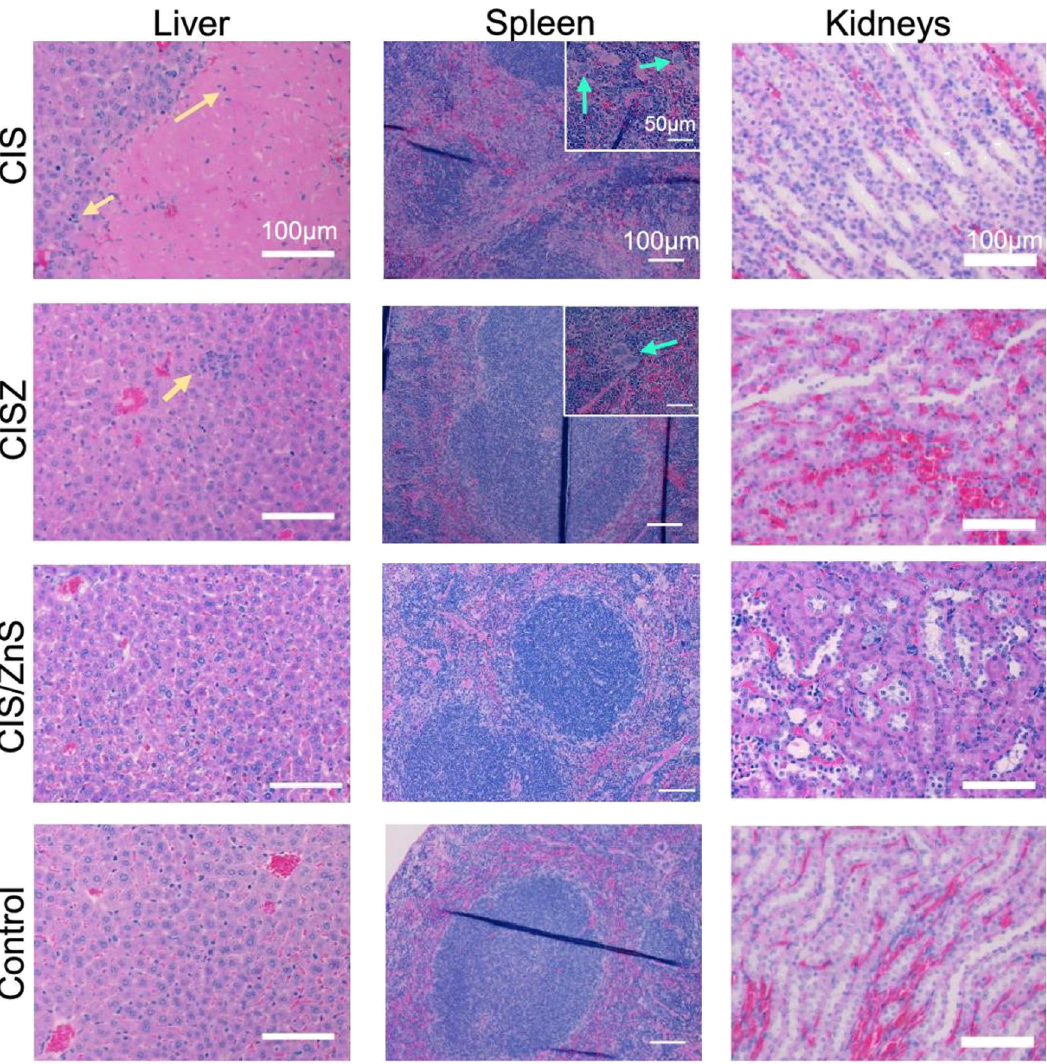
Figure 8: Micrograph of the organs ( liver, spleen, and kidney ) in the histopathological studies of QDs - dosed mice. The yellow arrow shows the in fl ammatory cells, while the blue arrow shows the multinucleated cells; with permission from ref. [ 129 ] ;